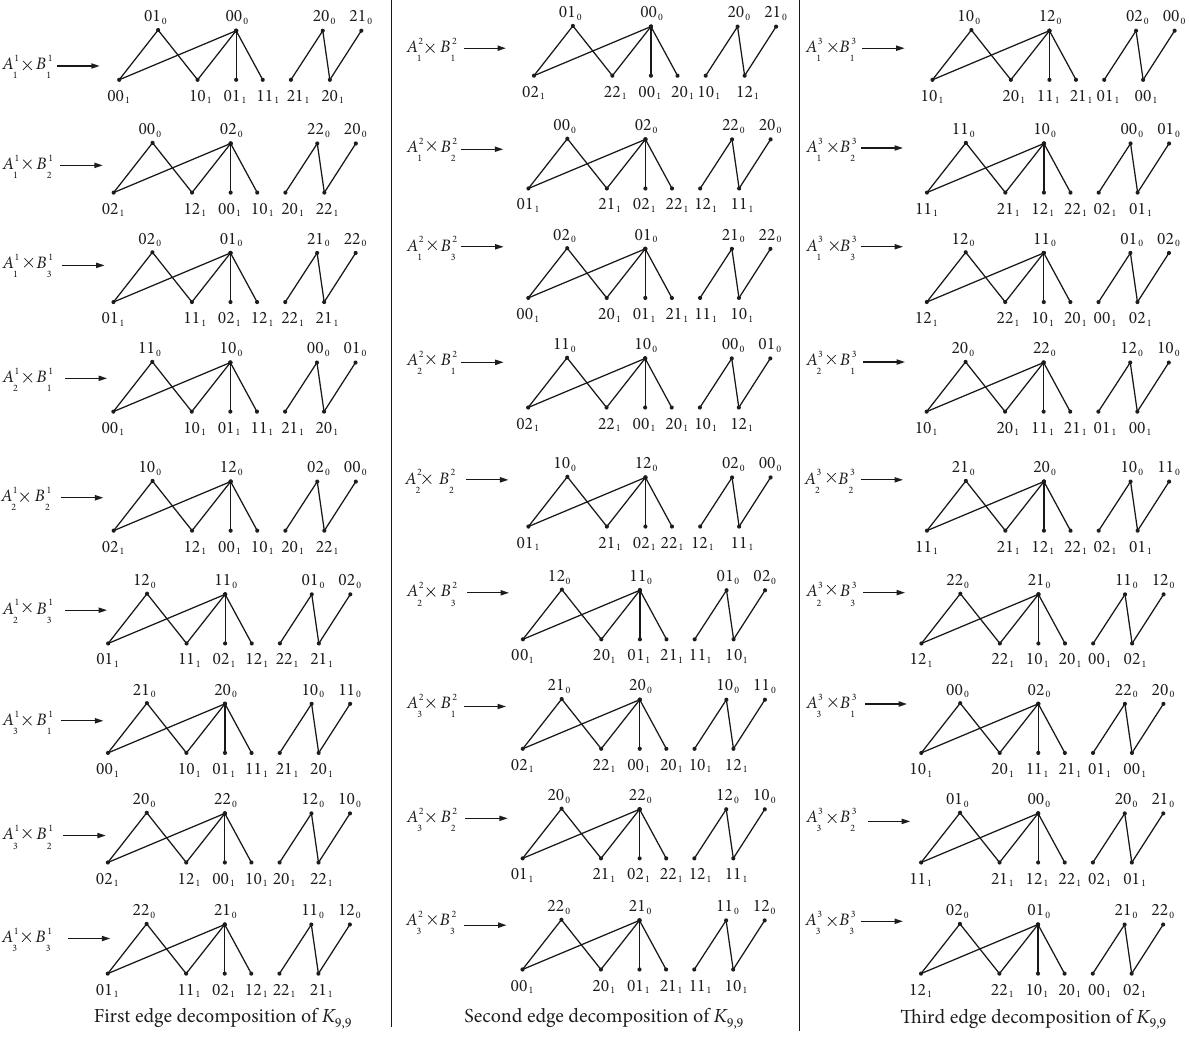
) ⊛ P by ( P ∪ K 9 , 9 3 2 4